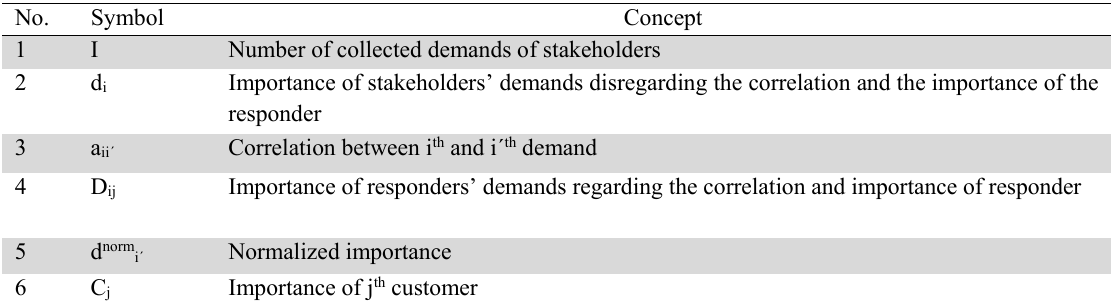
Concept of mathematical symbols